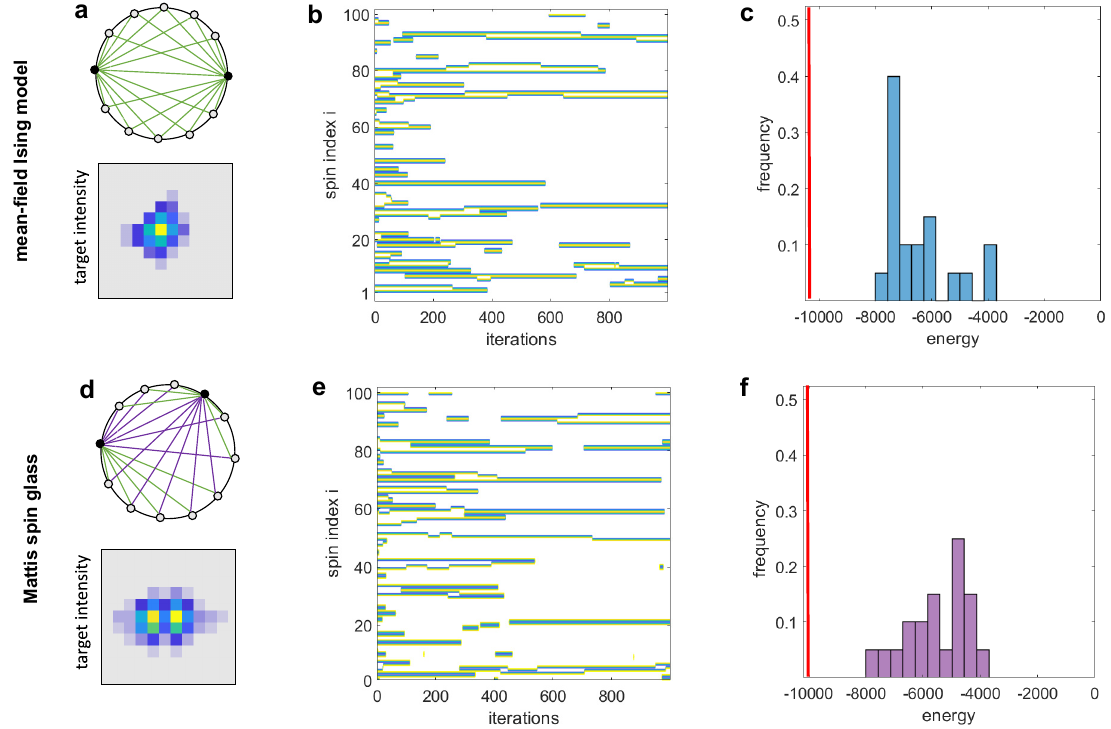
Figure 2: Ising machine ’ s ground states without noise control. (a – c) Results for ferromagnetic and (d – f) frustrated models with 100 spins ( ρ (cid:1) 0 ) . Problem graphs for (a) mean- fi eld (in fi nite-range) Ising model and (d) Mattis spin glass with positive and negative couplings. For clarity, only links starting from the two black nodes are drawn. Insets show the corresponding target images I T . (b, e) Contour maps showing theevolutionofthespincon fi gurationduringasinglerunofthemachine(greenregionsaredomainwalls).(c,f)Normalizedhistogramsofthe ground-stateenergyobtainedfortheinstancesin(a)and(d),respectively.Theredlinesin(c)and(f)indicatetheminimumenergyknownfrom exact solution of the